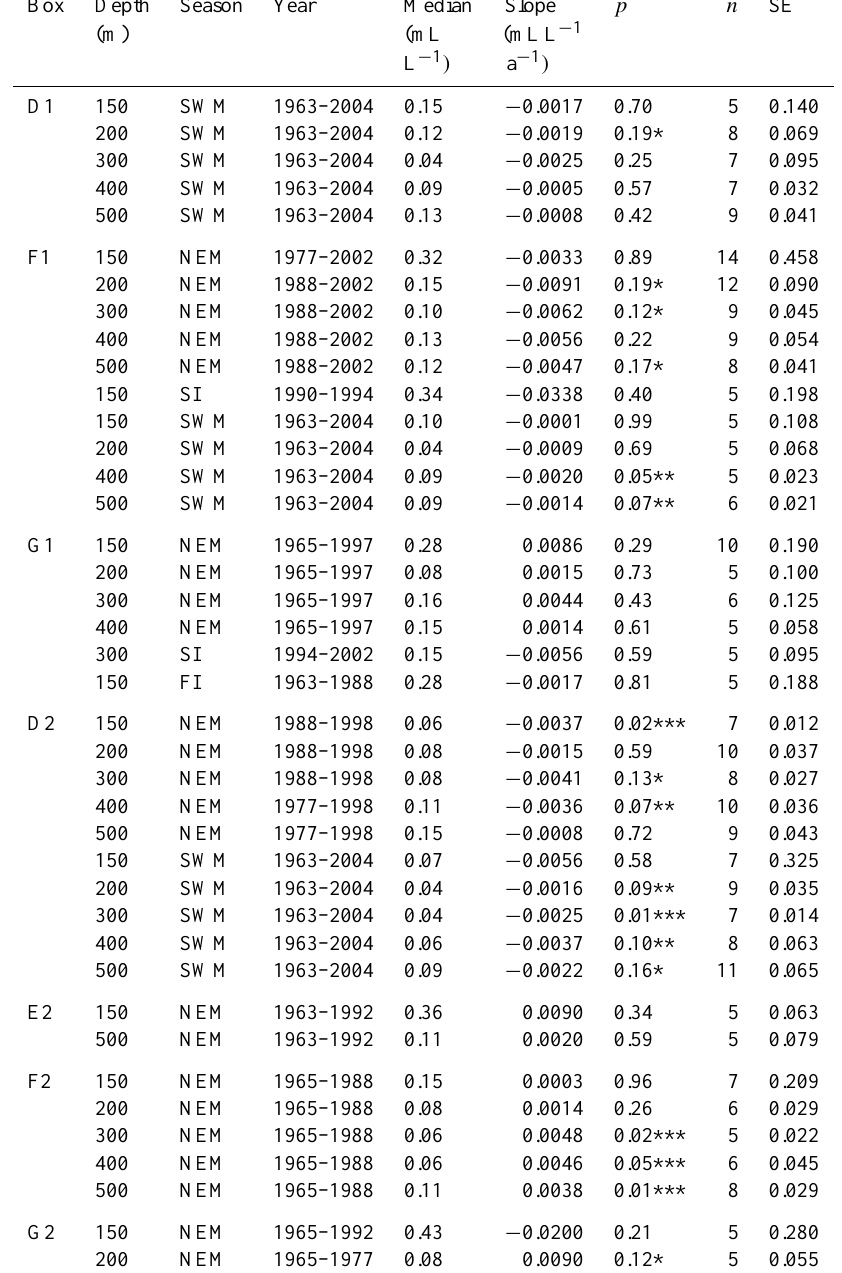
Table 5. Seasonal regressions of O 2 on year in OMZ with slopes and medians with n ≥ 5 ( p of slope: * ≤ 0.20; ** ≤ 0.10; *** ≤ 0.05; n number of values; SE: Standard Error of regression). See Fig. 3 for names and length of